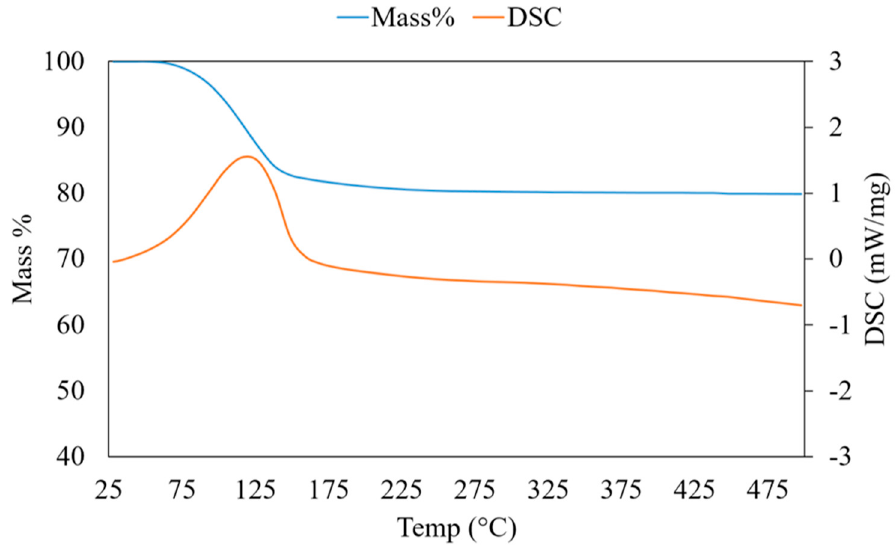
Figure 4. Thermal analysis (TGA-DSC) of the synthesized SAPO-34.